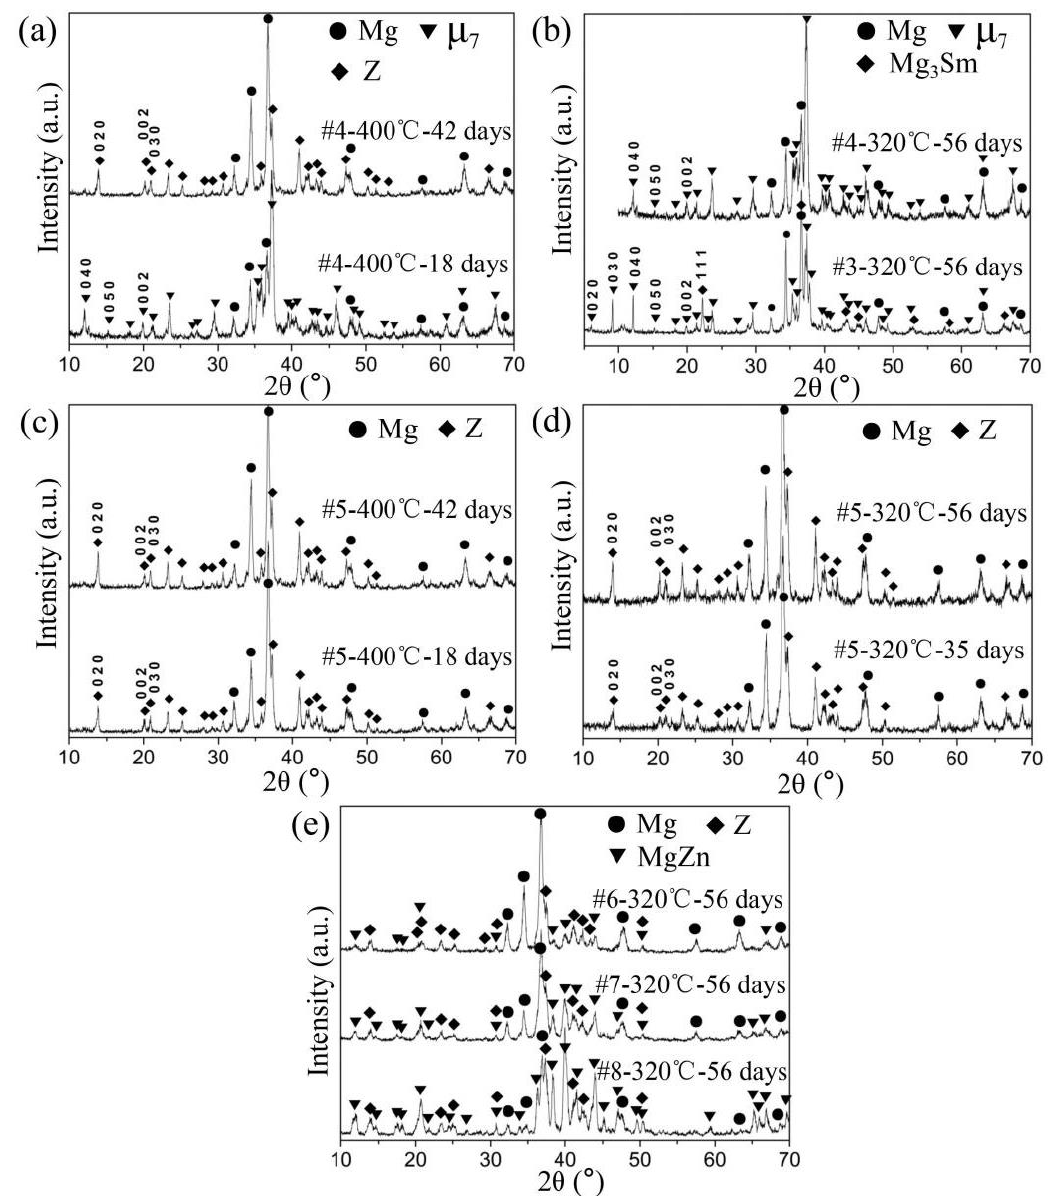
Figure 6. The XRD patterns of alloys #3 – #8 ( a – e ) annealed at 400 °C and 320 °C. The melting traces are observed on the surface of alloys #6 – #8 after annealing at 400 °C, and the microstructures are significantly different from those under as-cast conditions. As seen in Figure 7a–c, the liquid phase in the quenching samples has solidified into the eutectic structure or the binary compound Mg 7 Zn 3 . However, the Mg 7 Zn 3 phase is only stable at a narrow temperature range of 328–341 ◦ C according to the Mg-Zn phase diagram. Thus, it can be deduced that the phase equilibrium at 400 ◦ C is (Mg) + Z + liquid in alloys #6 and #7 while alloy #8 is within Mg 2 Zn 3 + Z + liquid three-phase region. The XRD patterns of alloys #6–#8 annealed at 320 ◦ C for 56 days are shown in Figure 6e. It indicates that these three alloys are within (Mg) + Z + MgZn three-phase region. As shown in Figure 7d–f, the phase fraction of MgZn in alloys from #6 to #8 gradually increases, corresponding to the significant rise of the diffraction intensity of